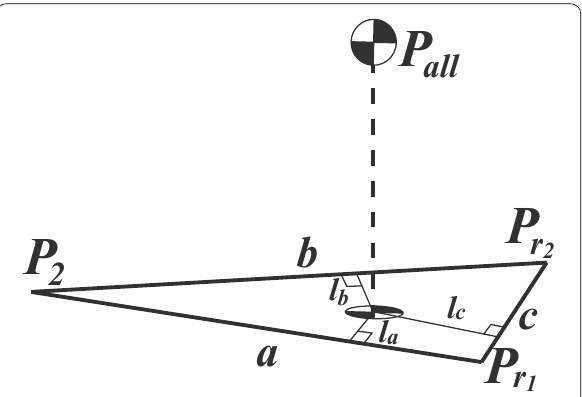
Fig. 18 Explanation for the optimal location of the P all and the contact